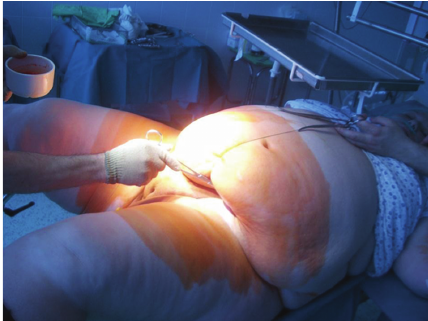
Figure 1: Preoperative preparation release of hanging abdomen to open the